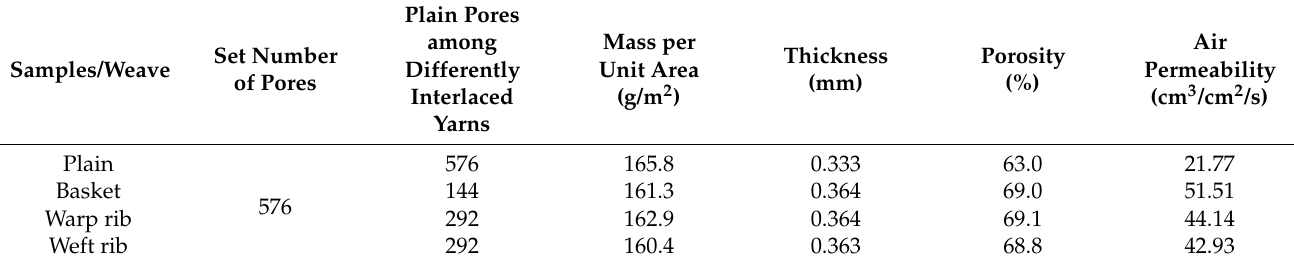
Table 3. Physical characteristics of optically examined fabrics and air permeability at 100 Pa.